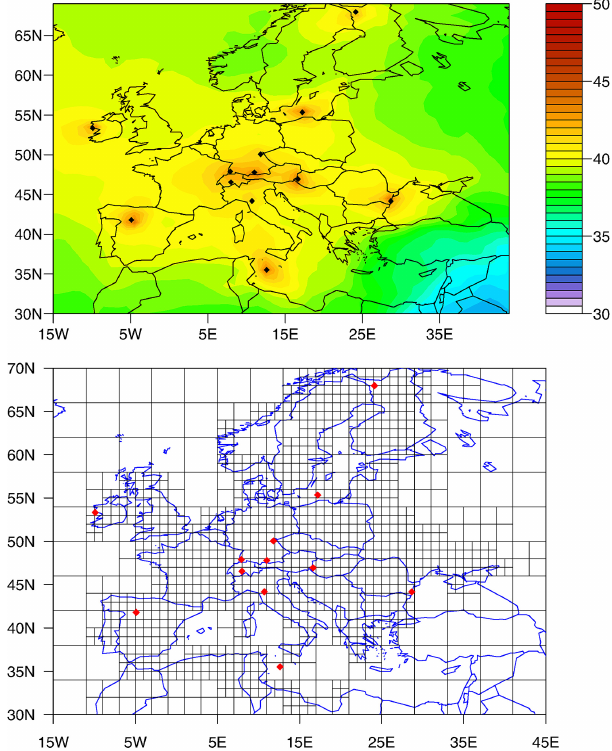
Figure 2. Total emission sensitivity for 2011 in units of log(sm − 3 kg − 1 ) calculated using FLEXPART and used to deter- mine the variable grid (note that for this no weighting is applied for the number of observations available from each site) (a) and the variable-resolution grid used in the inversion (b) . The points indi- cate the positions of the observation